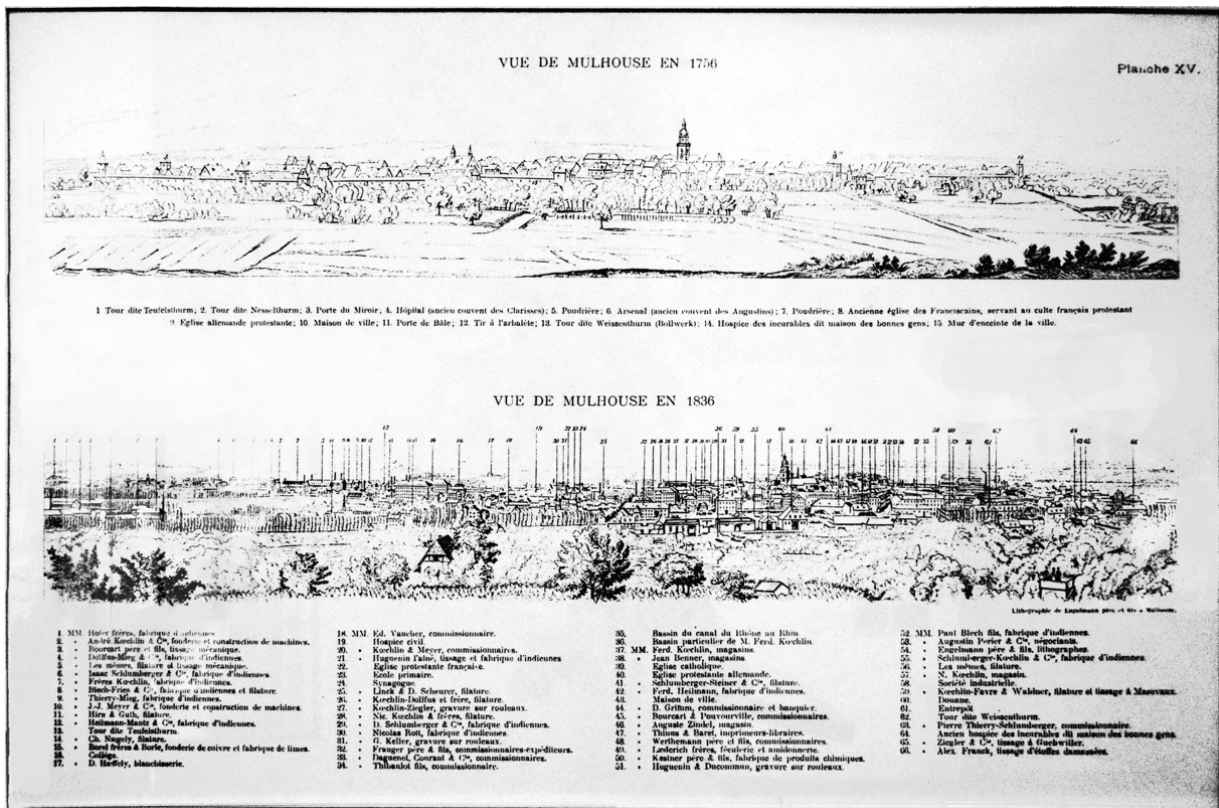
Figure 3. View of Mulhouse in 1756 and 1836. Lithograph by Godefroy Engelmann indicating the geographical location of all the factories and the civic buildings in Mulhouse and its peri‐urban territory. The image illustrates the radical growth of the city during the First Industrial Revolution. Source: Musée de l’Impression sur Étoffes